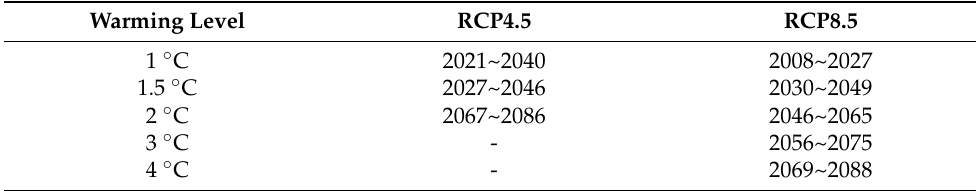
Table 1. Future periods in which warming over China reaches 1, 1.5, 2, 3, and 4 ◦ C under RCP4.5 and